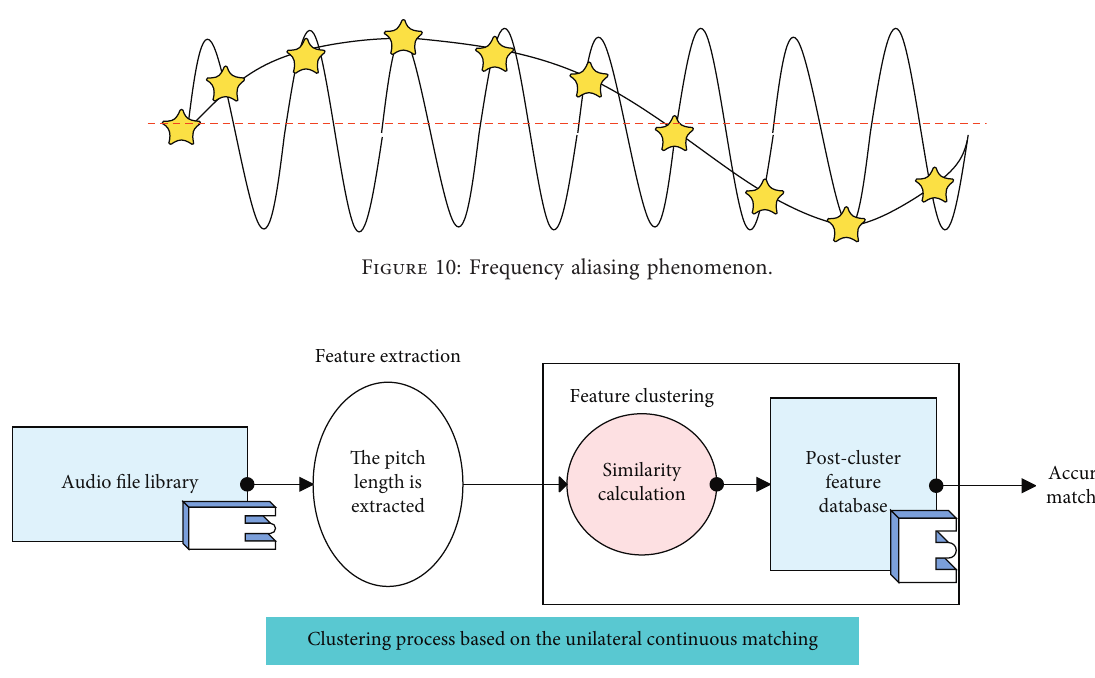
Figure 11: Block diagram of the hierarchical clustering